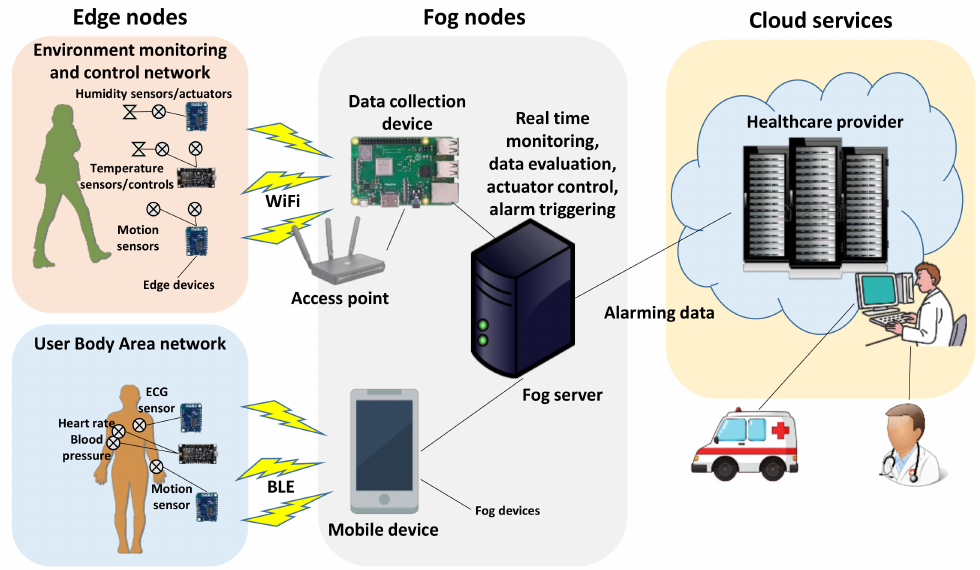
Figure 1. Three-layer Fog computing-based eHealth